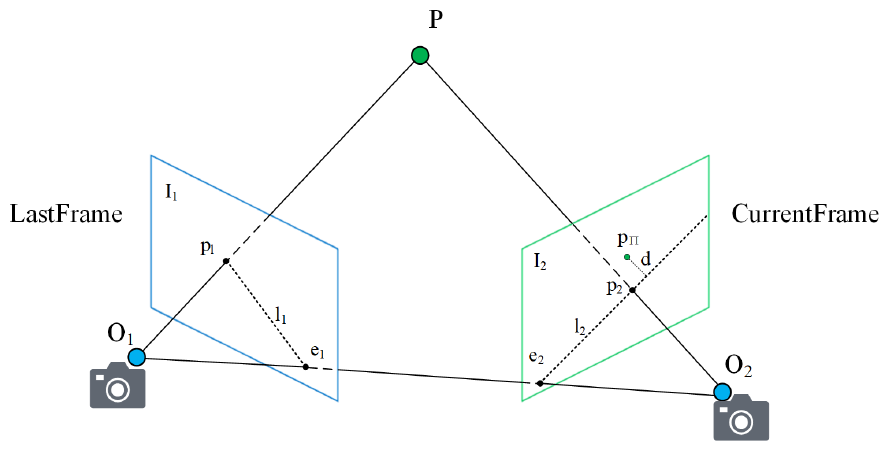
Figure 6. The epipolar